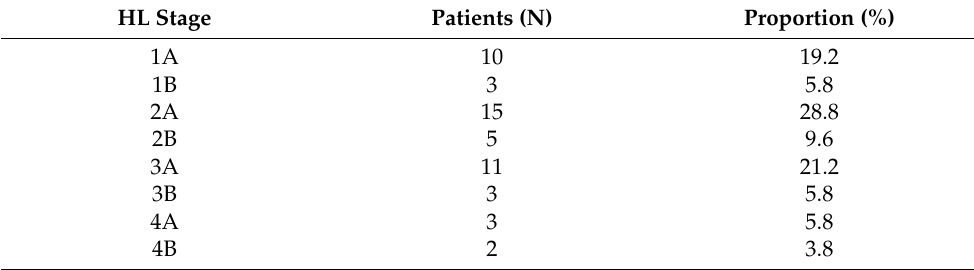
Table 2. Percentage distribution of the patient sample according to HL stage.